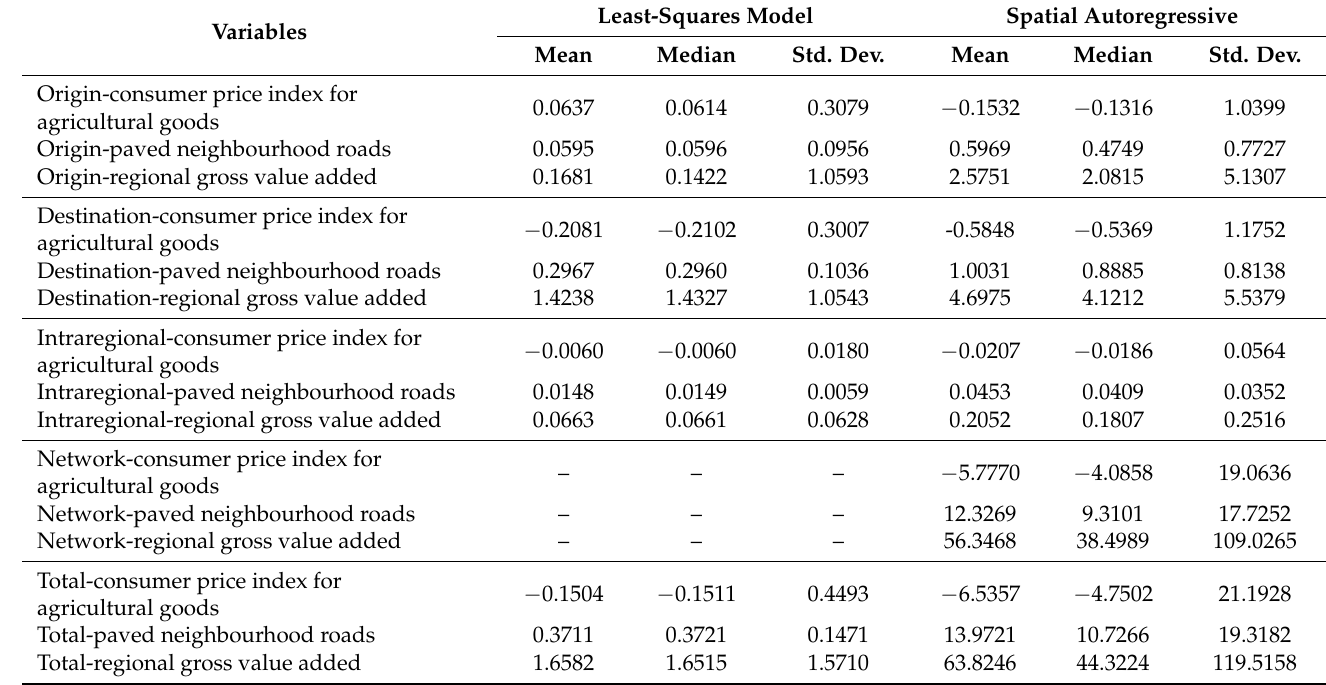
Table 5. Effect estimates for the least-squares and spatial autoregressive models. Least-Squares Variables